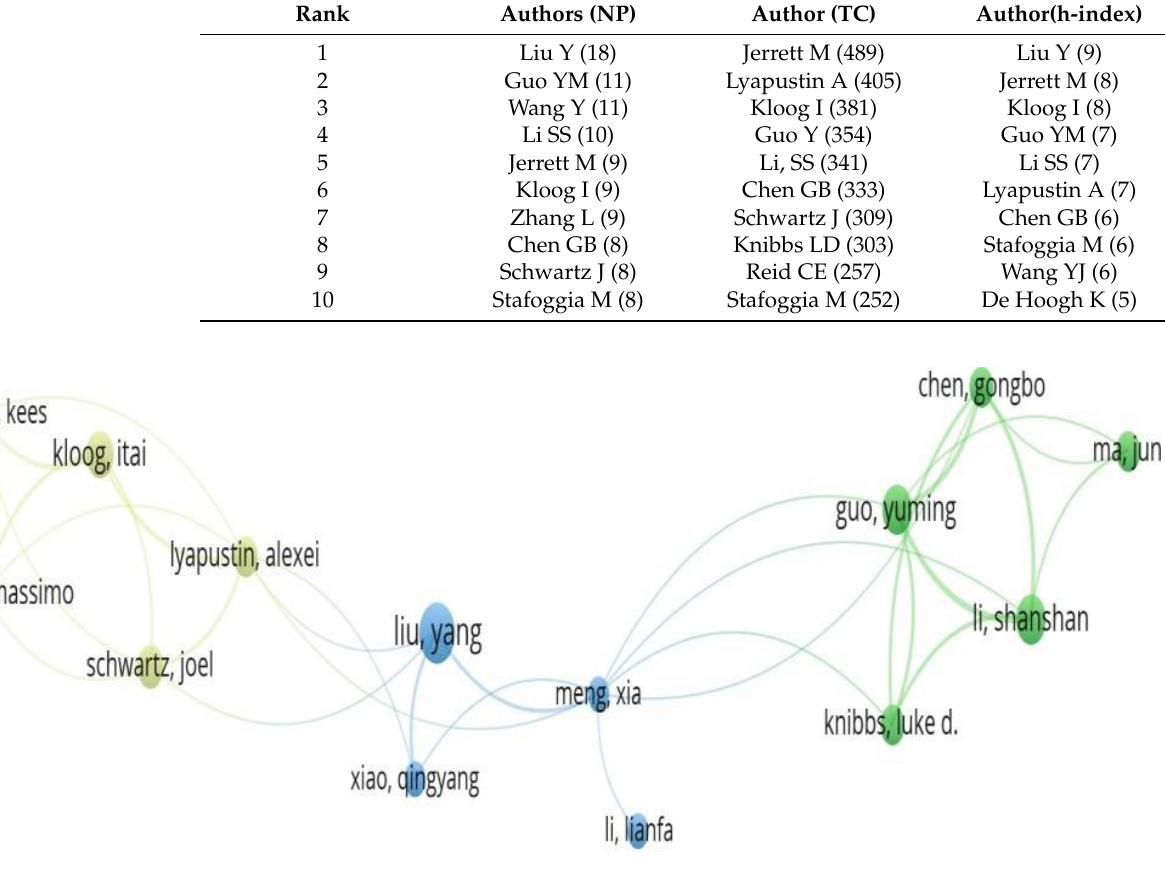
Figure 5. Map of co-authorship of prominent authors .